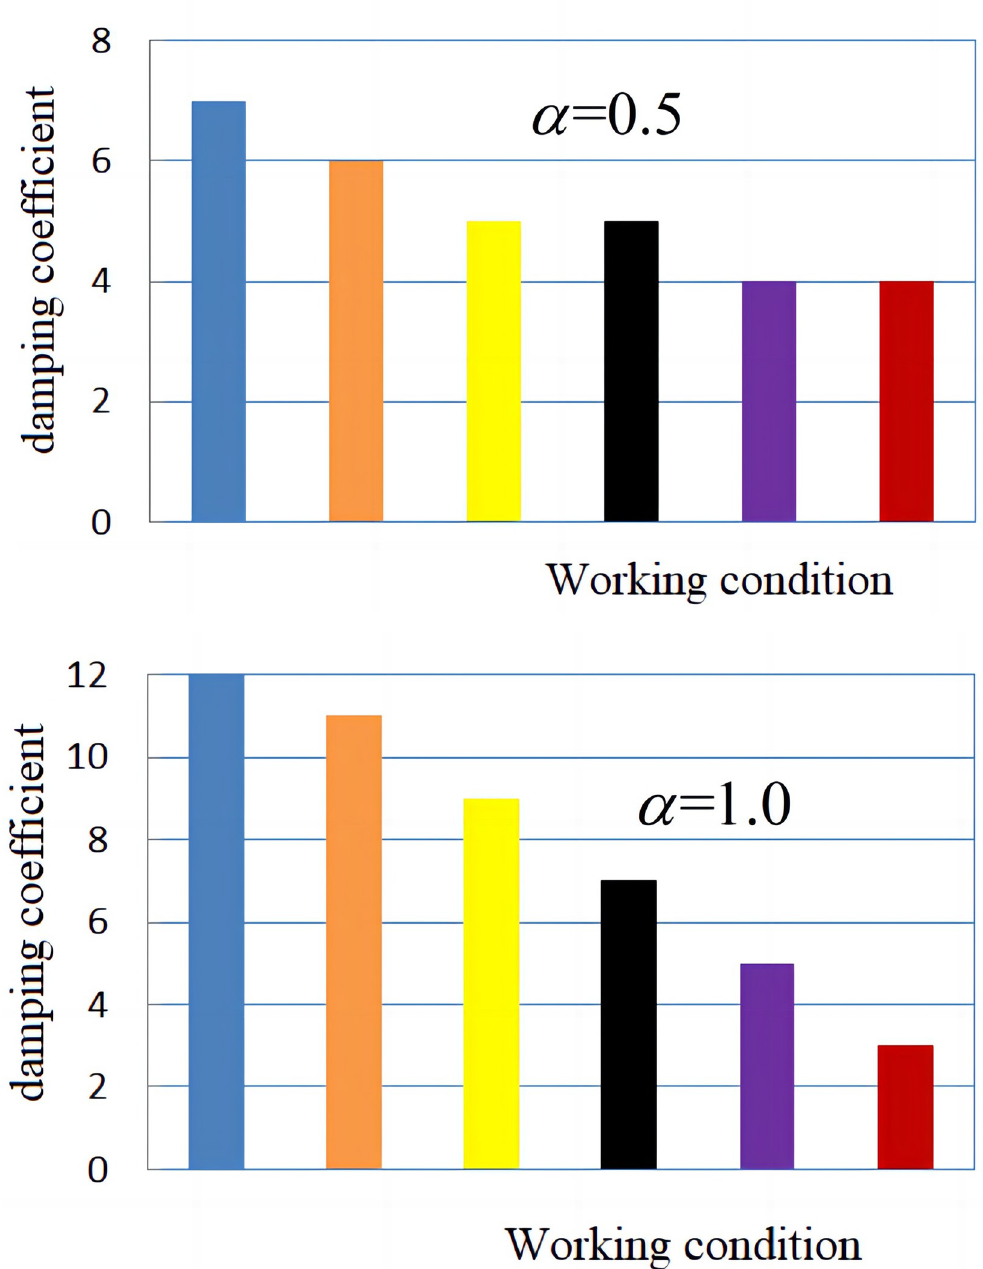
Fig 9. System damping coefficient curve under different conditions. (a) α = 0.5; (b) α = 1.0.